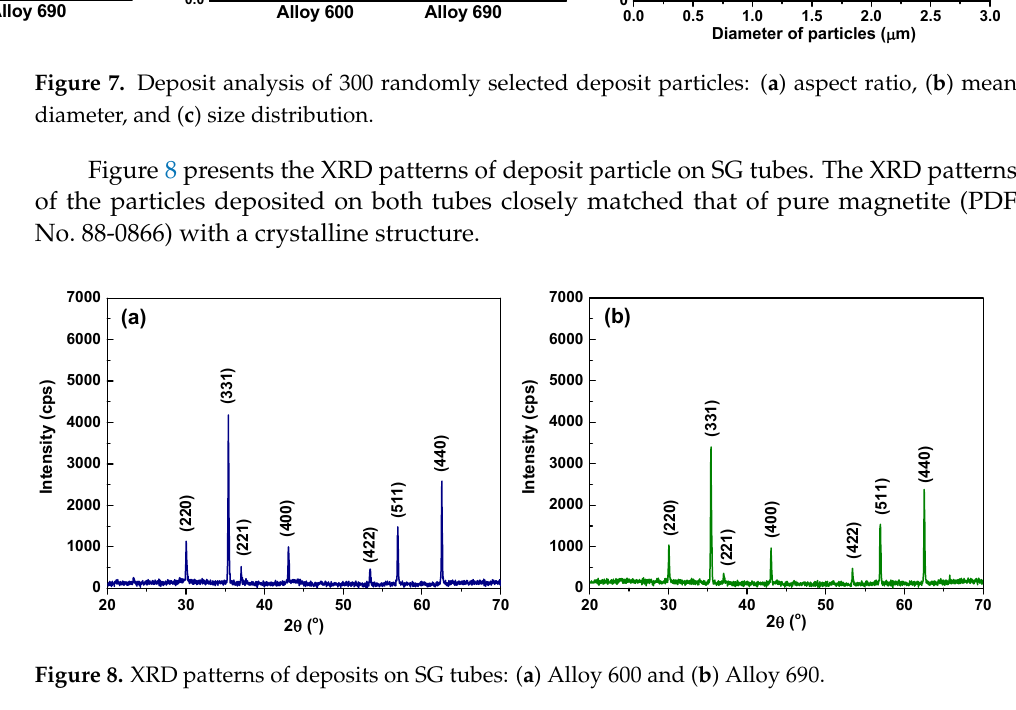
Figure 9. SEM ‐ EDS analysis of deposits of SG tubes: ( a ) Alloy 600 and ( b ) Alloy 690. Figure 10 presents cross ‐ sectional SEM images of magnetite deposits on SG tubes. Based on the results at three different locations, the thickness of the deposits on the Alloy 600 tube was approximately 35–50 μ m. In contrast, the deposits on the Alloy 690 tube were much thinner—about 25–35 μ m—than that on Alloy 600. However, as seen in Fig ‐ ures 6 and 10, the thickness of the deposit layer is not uniform over the tube surface. Hence, the amount of deposits on SG tubes should be evaluated by using ICP ‐ OES. A large number of pores existed within the deposits, as expected from Figure 6. It appears that the deposits on Alloy 600 are more porous than those on Alloy 690. Figure 10. SEM cross ‐ section images of magnetite deposits on two different SG tubes obtained using the FIB technique: ( a ) Alloy 600 and ( b ) Alloy 690.